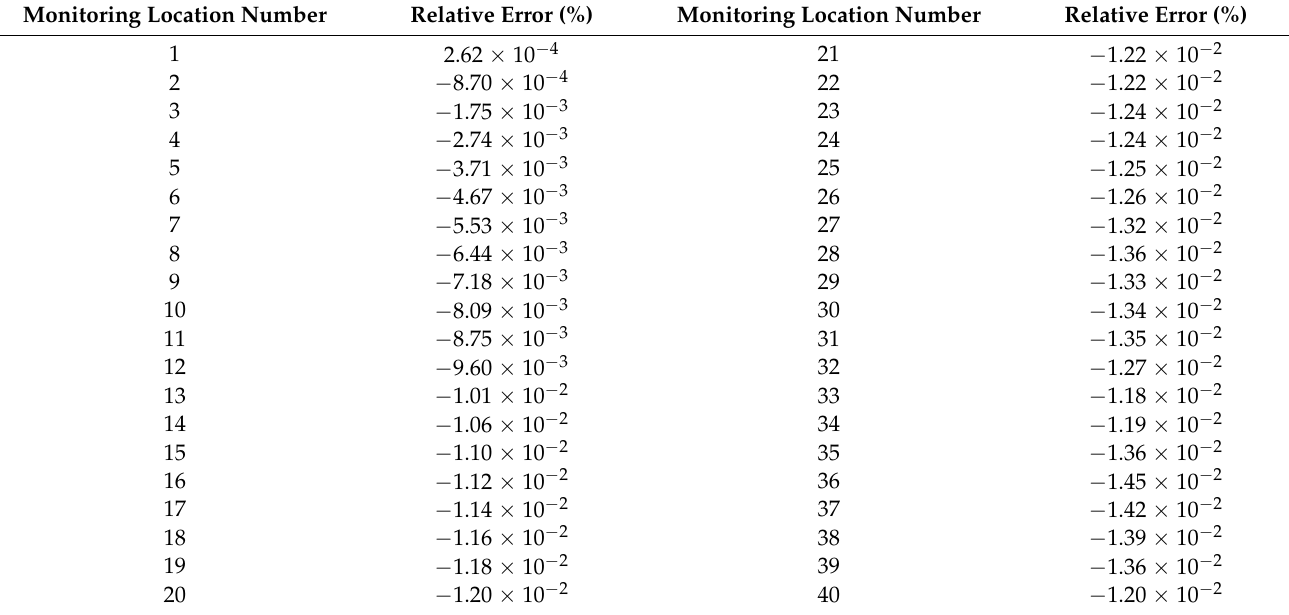
Table 5. Prototype and model relative